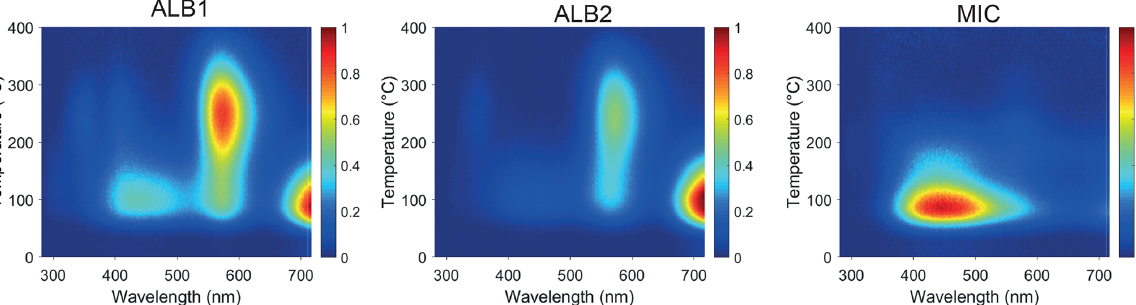
Figure 3. Thermoluminescence (TL) emission spectra recorded up to 400 ◦ C between ∼ 280 and ∼ 715nm for samples ALB1, ALB2, and MIC (untreated). TL intensities are normalised for aliquot mass, dose (270Gy), and electron multiplying gain to the highest TL intensity of the whole TL spectrum. Spectra are corrected for spectrometer efficiency.